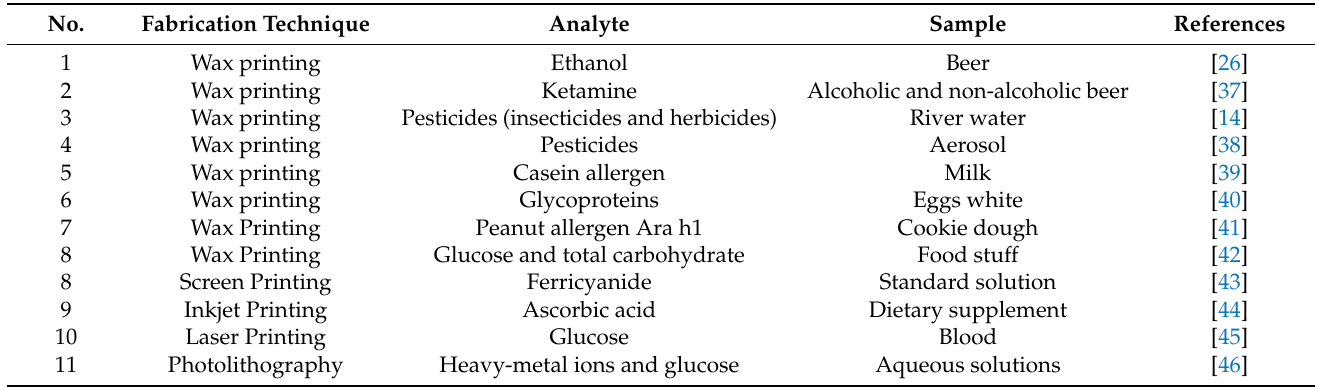
Table 2. Some examples of fabrication techniques for electrochemical PAD construction.